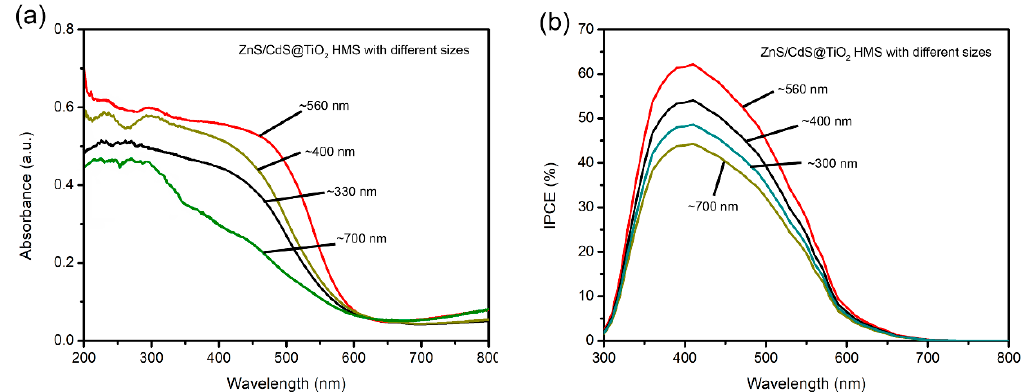
Figure 7. ( a ) UV-vis spectra of ZnS / CdS@TiO 2 HMS with di ff erent sizes; ( b ) IPCE of ZnS / CdS@TiO 2 HMS with di ff erent sizes.